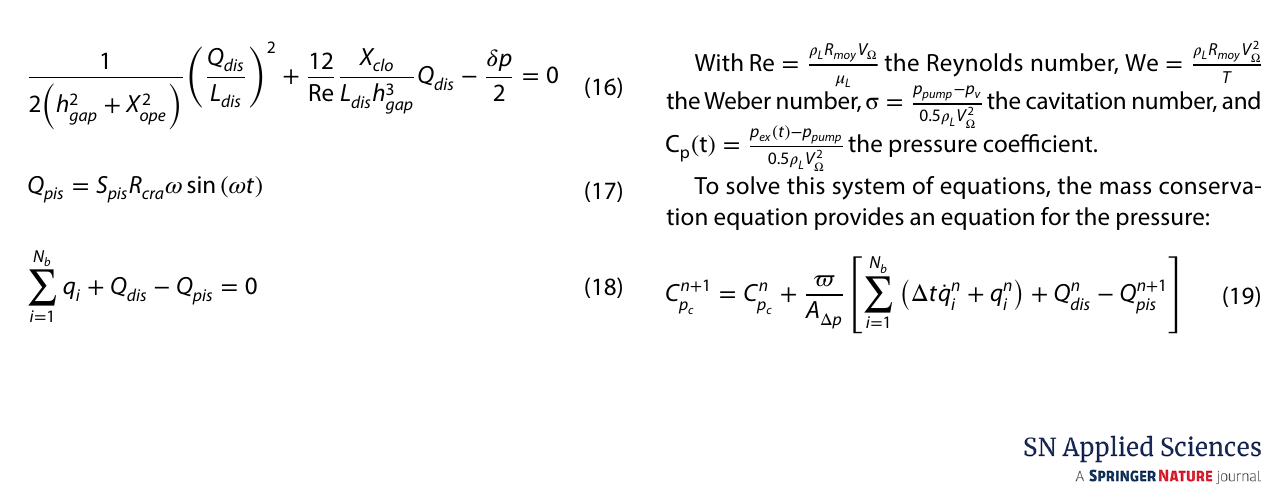
Fig. 3 Scheme of the system a distributor opened, b distributor closed, c and d zoom at the overlap in configurations b and a, respectively and e zoom at the distributor closing